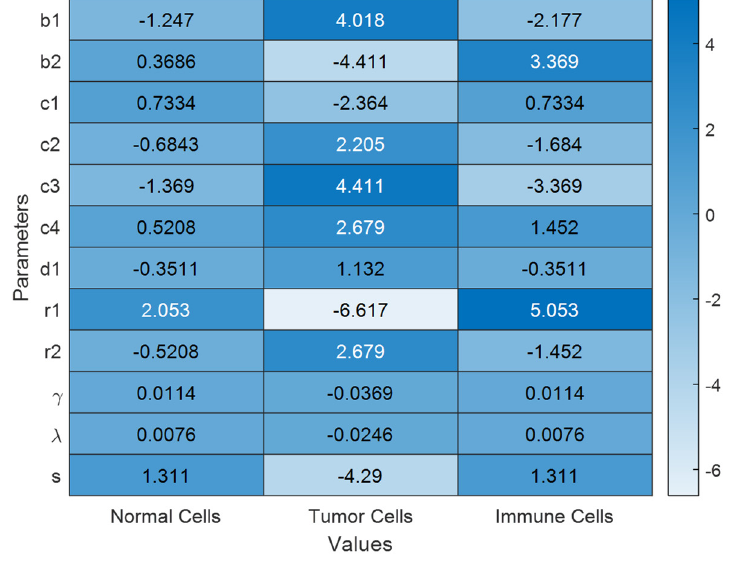
Figure 1. Sensitivity analysis.